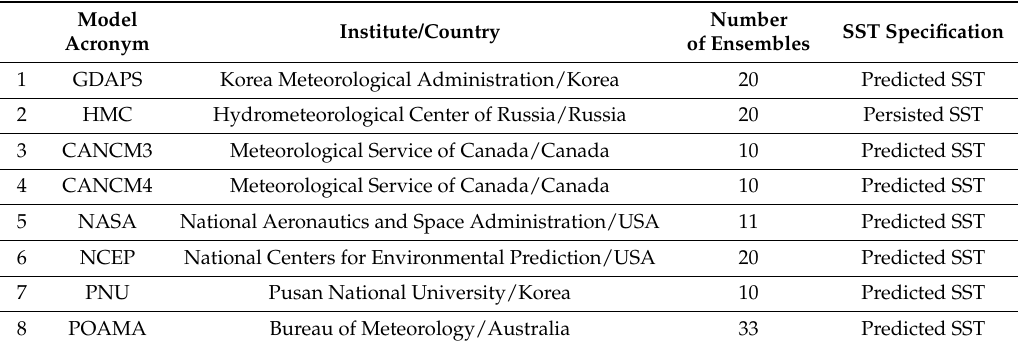
Table 1. Seasonal prediction models used in this